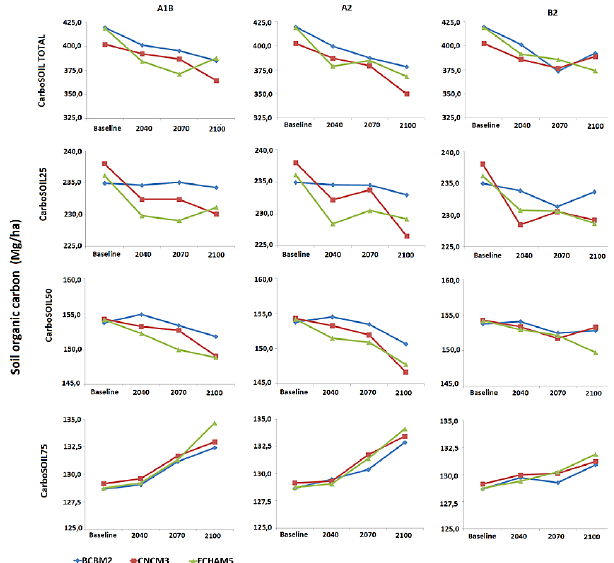
Fig. 4. Soil organic C stocks in climate change scenarios for each GCM and SRES in different periods (2040, 2070 and 2100) at dif- ferent soil depths: 0–25 (CarboSOIL25), 25–50 (CarboSOIL50),